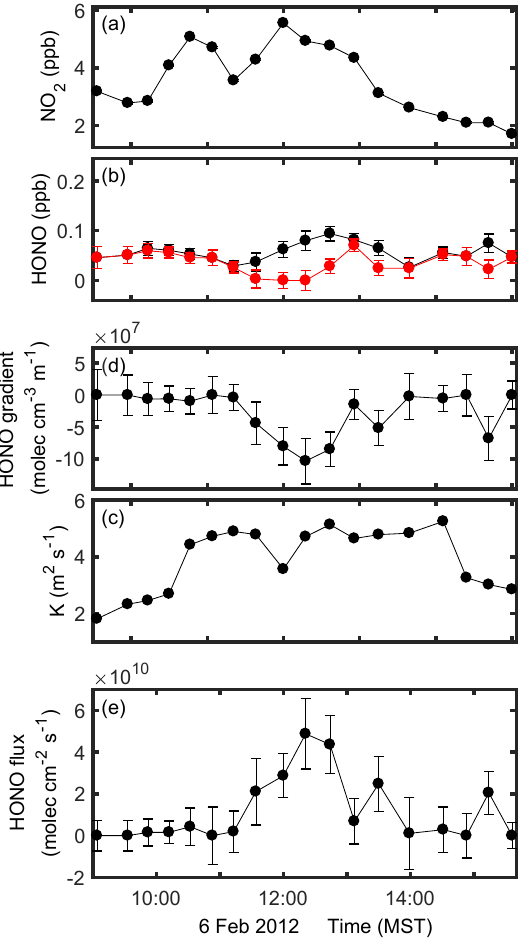
Figure 6. Mixing ratios of NO 2 on the lower light path (a) and HONO retrieved in the two height intervals (black: lower interval; red: upper interval) (b) . HONO concentration gradients calculated from the retrieved HONO mixing ratios (c) and observed eddy dif- fusivity coefficients (d) were used to calculate the vertical HONO flux on 6 February 2012 (e) . Error bars show the 1 σ uncertainty of the respective data